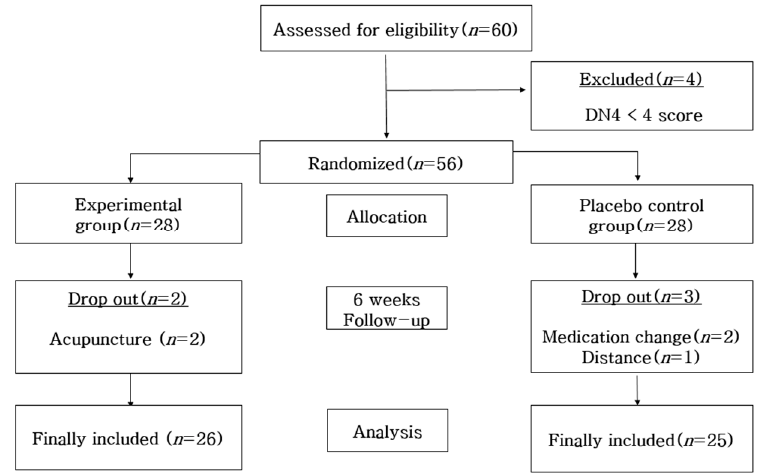
Figure 1. Participant selection flow.